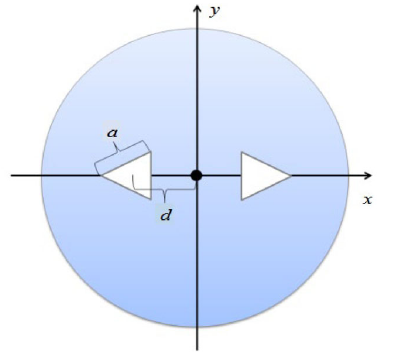
Fig. 6 Cross-section schematic of the triangular-core side-hole